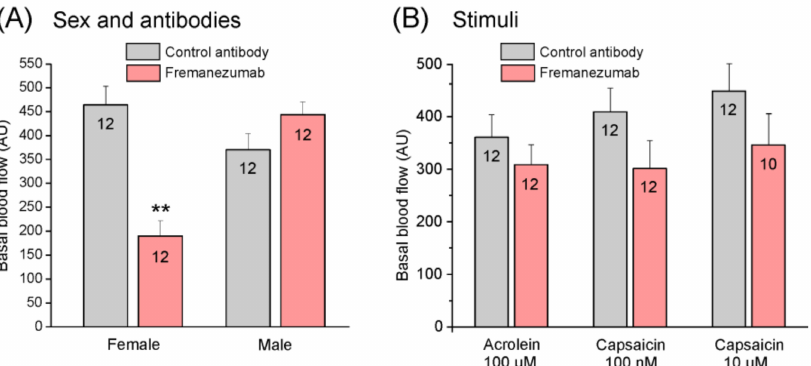
Figure 4. Basal blood flow of the dura mater (means ± SEM) of female and male rats 13–20 days after injection of either control antibody (grey) or fremanezumab (red) ( A ) and before stimulation with acrolein and capsaicin at two doses ( B ). Numbers within columns denote counts of experiments; **: p < 0.001 comparing the effect of control antibody and fremanezumab treatment on basal blood flow in females.